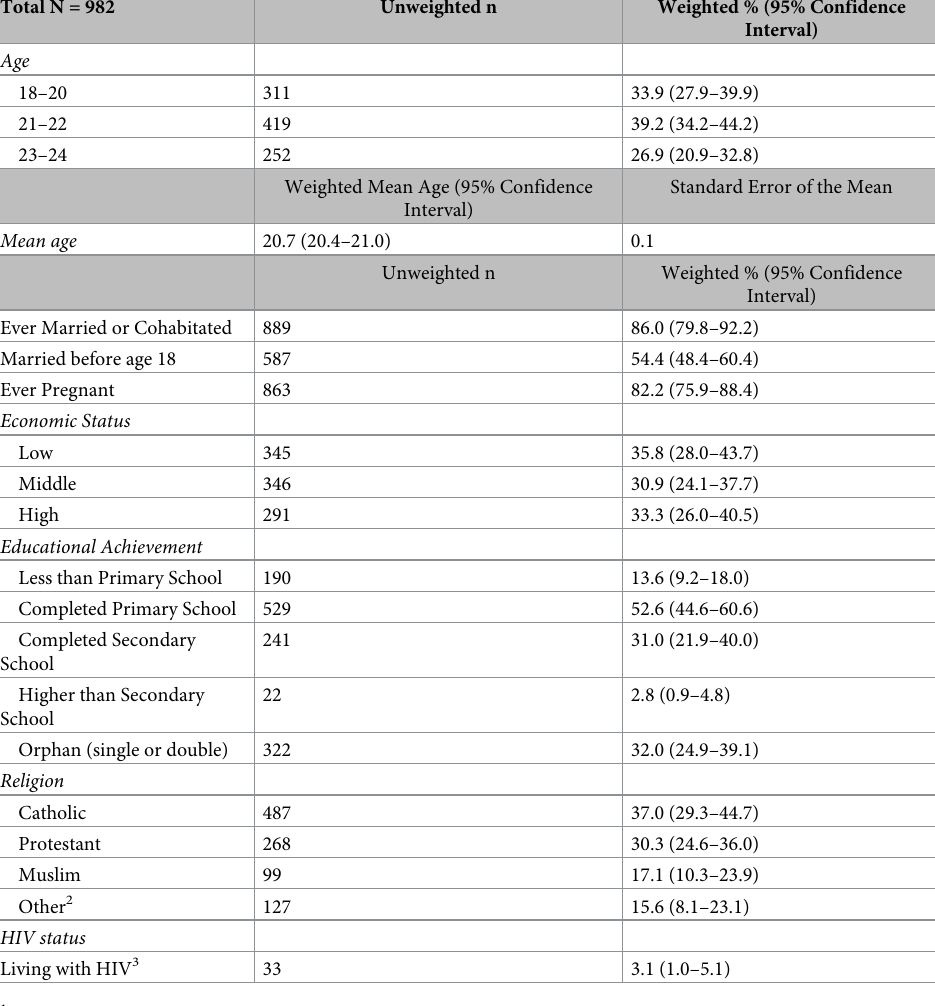
Table 1. Background characteristics of Ugandan females ages 18–24 who ever had sex prior to age 18, Uganda Violence Against Children Survey